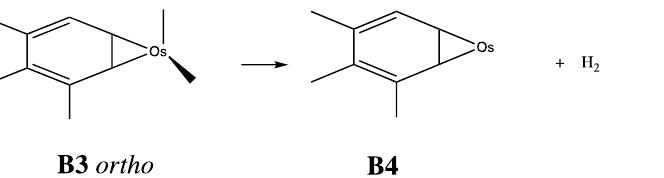
Figure 11. Landmarks for the extrusion of H 2 from cationic H 2 OsC 6 H 4 cis and trans C3 and from B4.